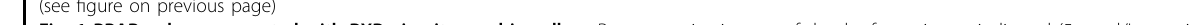
Fig. 1 PPAR γ phase separated with RXR α in vitro and in cells. a Representative images of droplet formation as indicated (5 μ mol/L protein, 150 μ mol/L NaCl, 10% PEG-8000). b Time-lapse micrographs of merging droplets (5 μ mol/L protein, 150 μ mol/L NaCl, 10% PEG-8000). c Phase diagram of PPAR γ in the presence of different concentrations of NaCl, displaying phase separation potential of the protein is dependent on salt concentration (10% PEG-8000). d Quanti fi cations of changes in the fl uorescence measurement of mEGFP-PPAR γ droplets after photobleaching were plotted over time (10 μ mol/L protein, 150 μ mol/L NaCl). The background was subtracted from the fl uorescence measurement. Values represent means ± SEM ( n = 15). Scale bar, 5 μ m. e Immuno fl uorescence assay for PPAR γ (green) or RXR α (red) in fi xed 3T3-L1 cells. Fluorescence signal is shown alone (left) or merged with DAPI stain (right). f FRAP recovery images and recovery curve of nuclear mCherry-PPAR γ condensates. The dotted square displays the region of photobleaching. Data are shown as means ± SEM ( n = 15). Scale bar, 10 μ m. g Confocal images of 3T3-L1 adipocytes transfected with mCherry-PPAR γ and mEGFP-RXR α for 48 h ( n = 20). Scale bar, 10 μ m. h FRAP analysis of PPAR γ /RXR α condensates. The dotted square displays the region of photobleaching. Scale bar, 5 μ m. i Quanti fi cation of changes in the fl uorescence measurement of PPAR γ /RXR α condensates after photobleaching were plotted over time. The background was subtracted from the fl uorescence measurement. Values represent means ± SEM ( n = 15). j Phase diagram of PPAR γ in the presence of different concentrations of RXR α (150 μ mol/L NaCl, 10% PEG-8000). k Representative fl uorescence microscopy images of a mixture of mEGFP-PPAR γ /mCherry, mEGFP/mCherry-RXR α and mEGFP-PPAR γ /mCherry-RXR α (2 μ mol/L protein, 150 μ mol/L NaCl, 10% PEG-8000), respectively. Scale bar, 5 μ m. l Column scatter charts display average droplet area of each image related to panel k . Data are shown as means ± SEM ( n = 5). m FRAP analysis of PPAR γ alone or PPAR γ /RXR α droplets (5 μ mol/L protein, 150 μ mol/L photobleaching were plotted over time. The background was subtracted from the fl uorescence measurement. Values represent means ± SEM ( n = 15). One-way analysis of variance (ANOVA) for panel l . *P < 0.05, ** P < 0.01, *** P < 0.001, **** P < 0.0001. ns, not signi fi